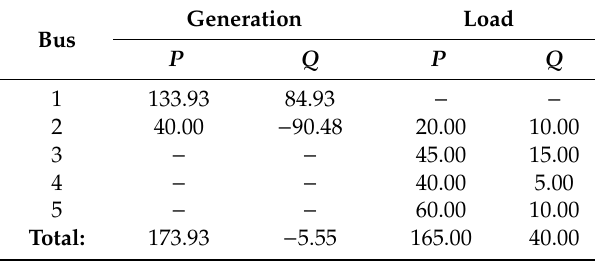
Table A8. Results of the mixed AC / DC PF calculations in Case 3. AC bus data.